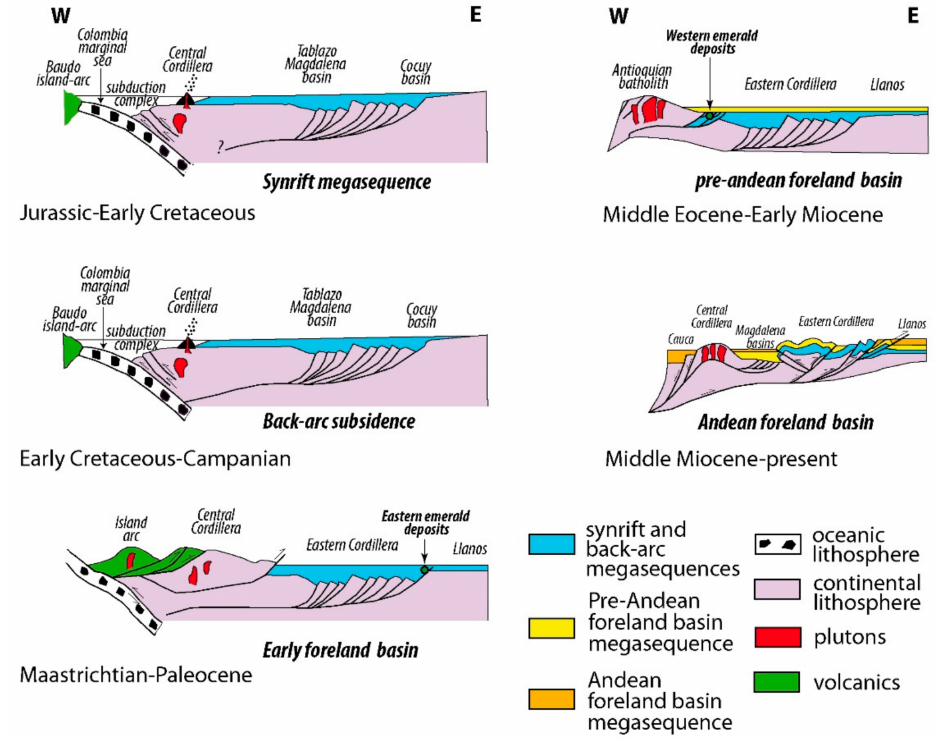
Figure 26. Basin development and tectonic history of the Llanos and Eastern Cordillera basins, and Middle Magdalena Valley in Colombia (modified from [109]). Four episodes of deformation have been recognized in the Tertiary of central Colombia: ( 1 ) Late Cretaceous–early Paleocene, with the formation at 65 Ma of the emerald deposits from the eastern zone; ( 2 ) middle Eocene with the creation of folds and thrusts in the Middle Magalena valley and western border of the Eastern Cordillera basin, and with the formation, between 38–32 Ma, of the emerald deposits from the western; ( 3 ) late Oligocene–early Miocene; and ( 4 ) late Miocene–Pliocene at 10.5 Ma where the Eastern Cordillera was uplifted and eroded, with the outcropping of the emerald deposits from the eastern and western emerald